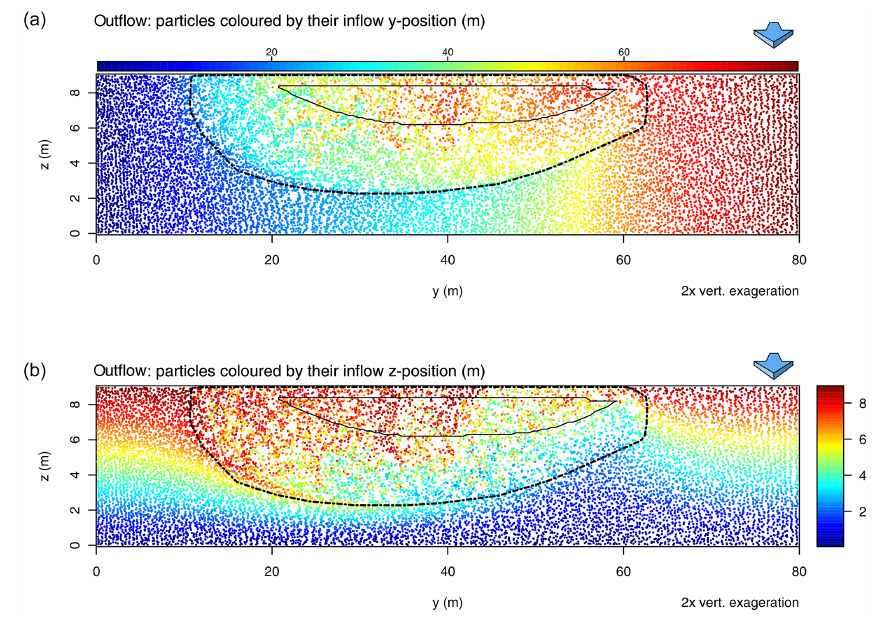
Figure 8. Particles on the model outflow face coloured by their (a) y coordinate position and (b) z coordinate position on the inflow face. The black line represents the shape of the trough fills projected on the outflow face and the dashed line represents the convex hull of the particles on the outflow face that flowed through the trough fills. The blue arrows indicate the main flow direction.